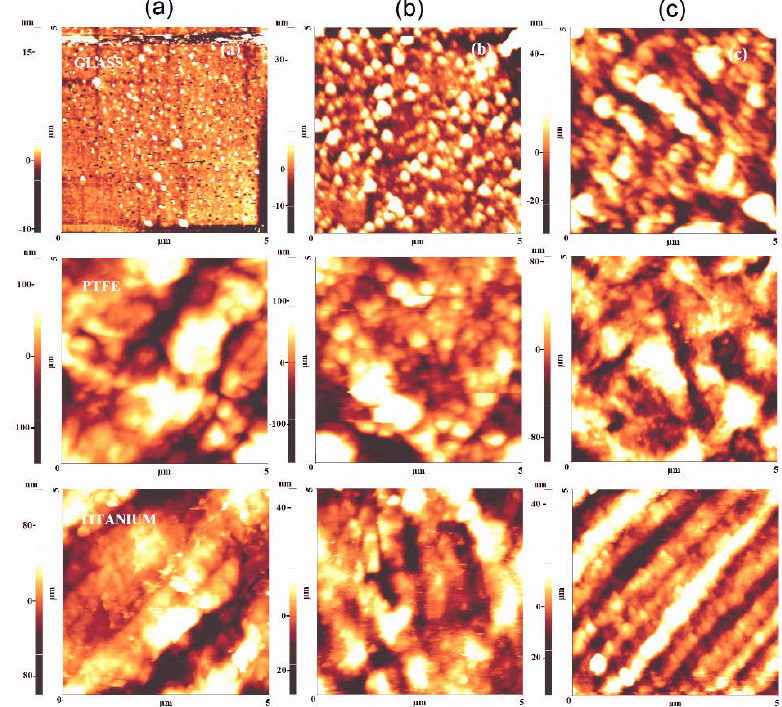
Figure 12. Atomic force microscopy (AFM) images of thin films deposited on glass, PTFE and titanium in DC plasma jet (nitrogen/air): ( a ) Control, ( b ) Condition A, and ( c ) Condition B.